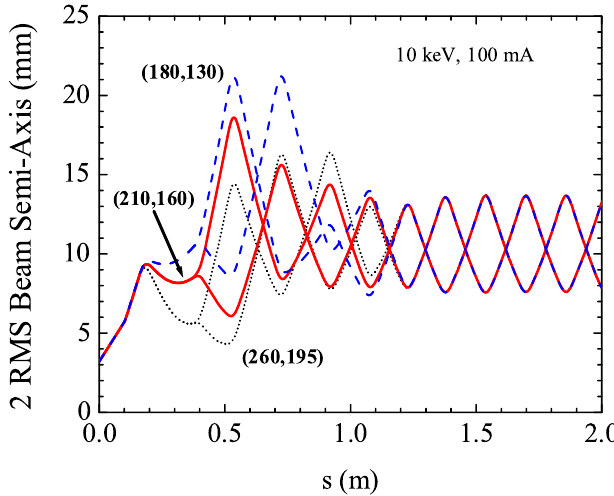
FIG. 7. (Color) Envelope-matching calculations for a 100 mA, 10 keV, (cid:4) (cid:5) 60 (cid:10) m electron beam in UMER. The matching section consists of one solenoid and seven PC quadrupoles (see (cid:5) 72 : 92 (cid:12) are shown ( SPOT code Fig. 1). Three solutions for (cid:5) 0 with smooth-gradient quadrupoles). The maximum value on the vertical axis corresponds to the vacuum pipe radius. The num- bers in parentheses indicate the peak strengths (in m (cid:4) 2 ) of the solenoid and first quadrupole (see Table IV for complete pa-